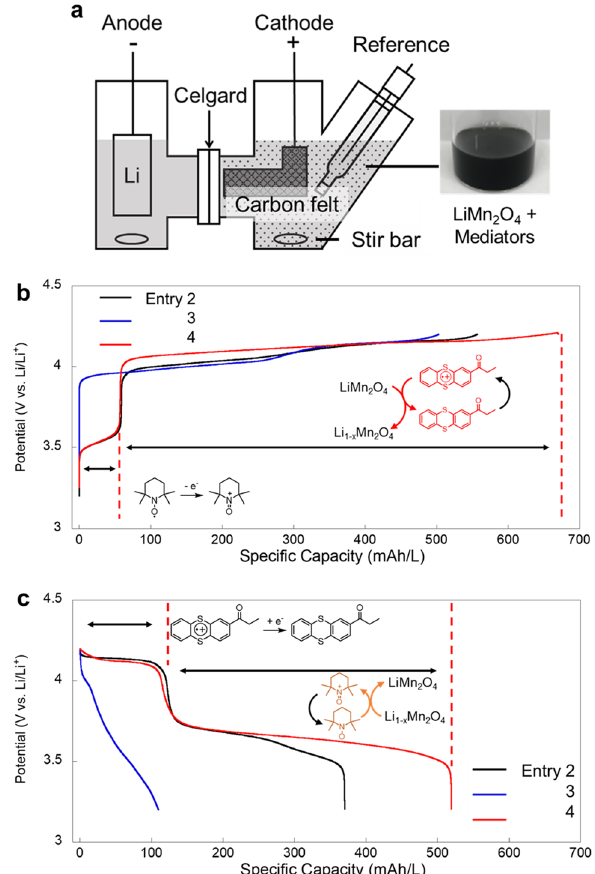
Figure 2. ( a ) Configuration of an H-type cell. In the catholyte, LiMn 2 O 4 was dispersed at a concentration of 670 mAh/L. Charging and discharging mediators were dissolved at a concentration of 67 + 67 mAh/L. ( b ) Charging and ( c ) discharging curves for the cells (Entries 2–4). The operation rate was set to be 0.5 C against the